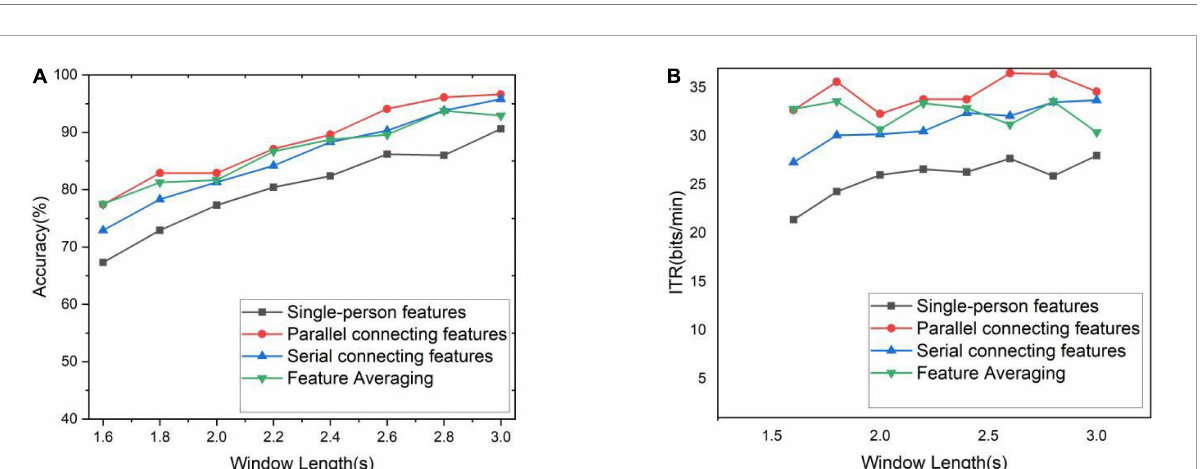
FIGURE5 Accuracy and ITR under different time windows. (A) Classification accuracy for different time windows. (B) ITR for different time